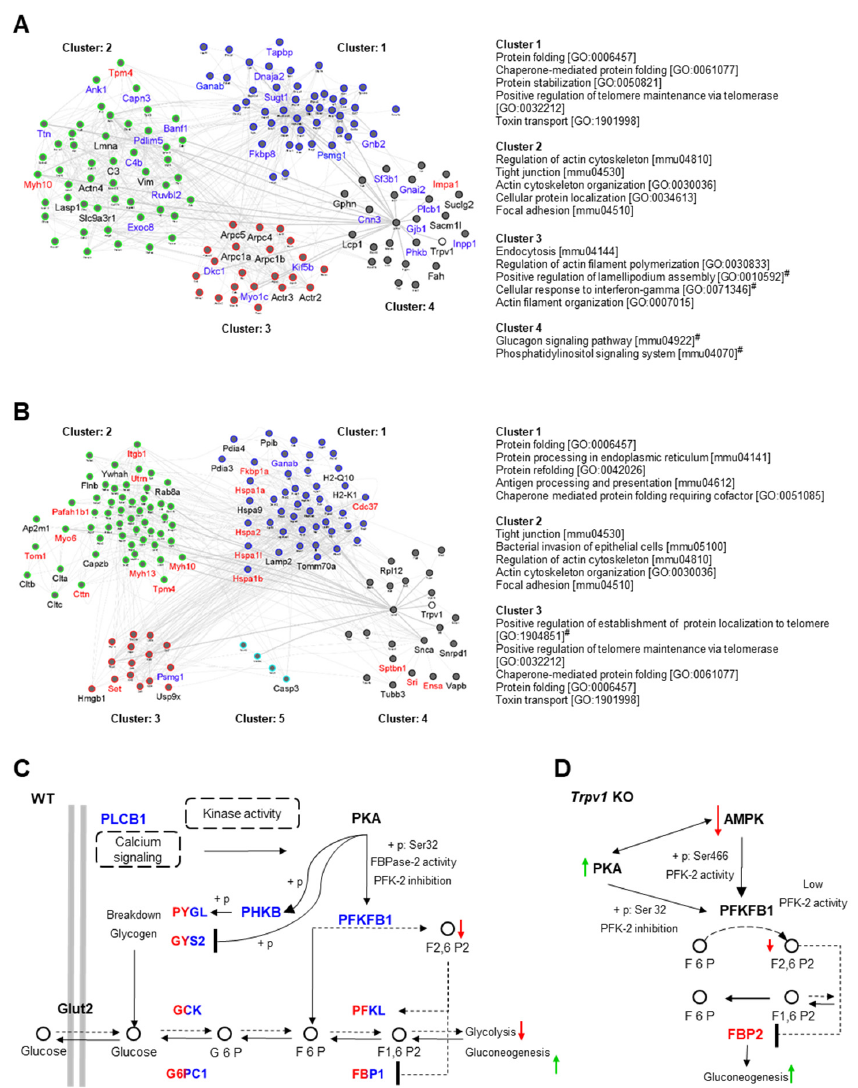
Figure 4. Network propagation highlights important liver clustering pathways and biological networks in the absence of TRPV1 channels. Network propagation of the TRPV1 channel in the liver of WT ( A ) and Trpv1 KO mice ( B ). TRPV1 protein input under each network served as a driver for network propagation in Trpv1 KO and WT. Separately propagated subnetworks with 141 proteins found to be significant in the propagation were clustered into smaller subnetworks and annotated using integrated enrichment analysis (GO-BP and KEGG pathway) to identify functional networks that are different between two propagated subnetworks (EnrichmentMap FDR < 0.01). Node names represent the proteins exclusively found in each propagated subnetwork; black for proteins shared between Trpv1 KO and WT proteomes; blue for proteins only found or upregulated in the WT proteome; red for proteins only found or upregulated in the Trpv1 KO proteome. Cluster title indicates the top five most significant biological function(s) for each cluster, and (#) refers to the KEGG pathway/GO-BP annotations exclusively enriched in each propagated subnetwork. ( C ) Framework of propagated network integration for enriched glucagon signaling pathway from KEGG in the WT proteome. ( D ) Framework shows proposed modulation of FBP-2 by PKA and AMPK kinases in Trpv1 KO mice resulting in more active gluconeogenesis than in WT mice. Blue nodes for proteins only found in the WT proteome, dual colors (blue/red) for proteins shared among proteomes, and black for proteins not found in the proteomic data. (+p) refers to phosphorylation and ( − p) to dephosphorylation.